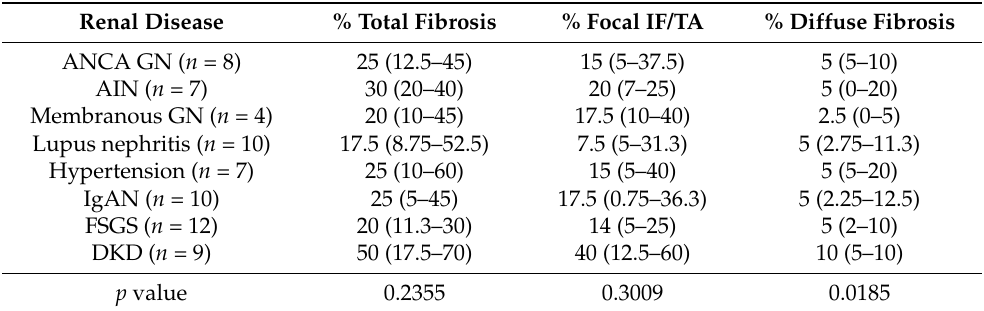
Figure 1. Distribution of focal IF/TA and diffuse fibrosis in experimental kidney diseases with different types of injury. ( A ) Representative photomicrograph of Masson’s trichrome-stained kidney section in mouse models of experimental kidney diseases (scale bars: 200 µ m). ( B ) The scatter dot plots represent medians with individual data points summarizing the extent of total kidney fibrosis in indicated experimental models ( n = 5 mice in each group). ( C ) The bar graph represents the fraction of focal IF/TA and diffuse fibrosis relative to total fibrosis in the indicated experimental models ( n = 5 mice in each group). Abbreviations: FAN—folic acid-induced nephropathy; IF/TA—interstitial fibrosis/tubular atrophy; NTN—nephrotoxic serum-nephritis; UUO—unilateral ureteral obstruction. Table 2. Distribution of total fibrosis, focal IF/TA, and diffuse renal fibrosis among various renal